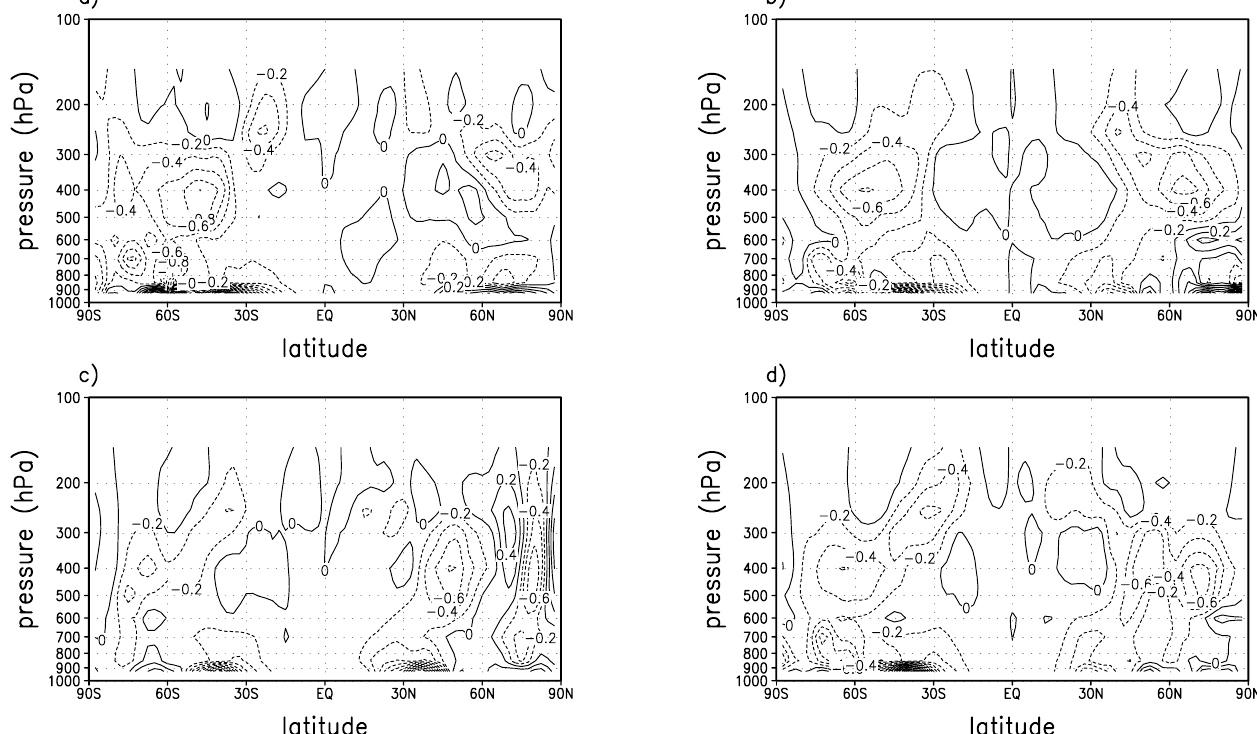
Fig. 2. Same as in Fig. 1 but for: (a) July 1995, (b) October 1995, (c) January 1996 and (d) April